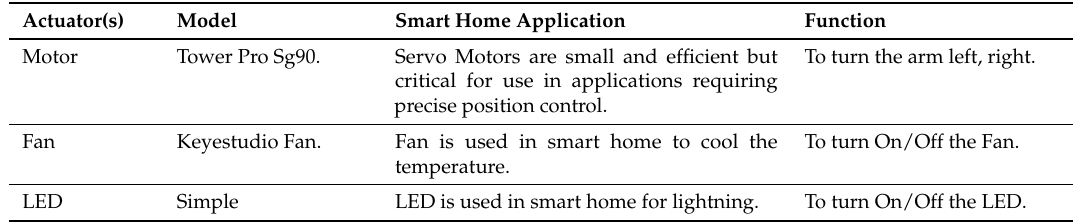
Table 4. Detail information of actuators used in experimental